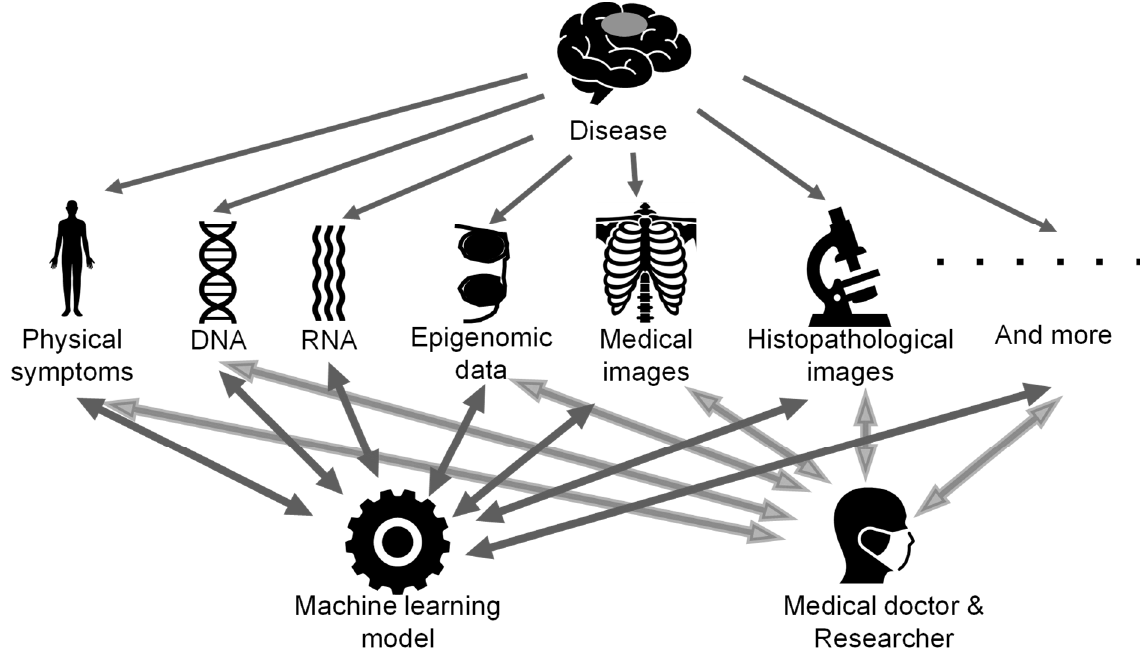
Figure 5. The concept art for future multi-omics analysis. Various types of data are obtained for garnering a better understanding of the nature of the disease and are integrated by machine learning models as well as humans. Supplementary Materials: The following are available online at www.mdpi.com/xxx/s1, Table S1: Studies reviewed in Table 1 grouped by input data category. Table S2: Studies reviewed in Table 1 grouped by input dataset.